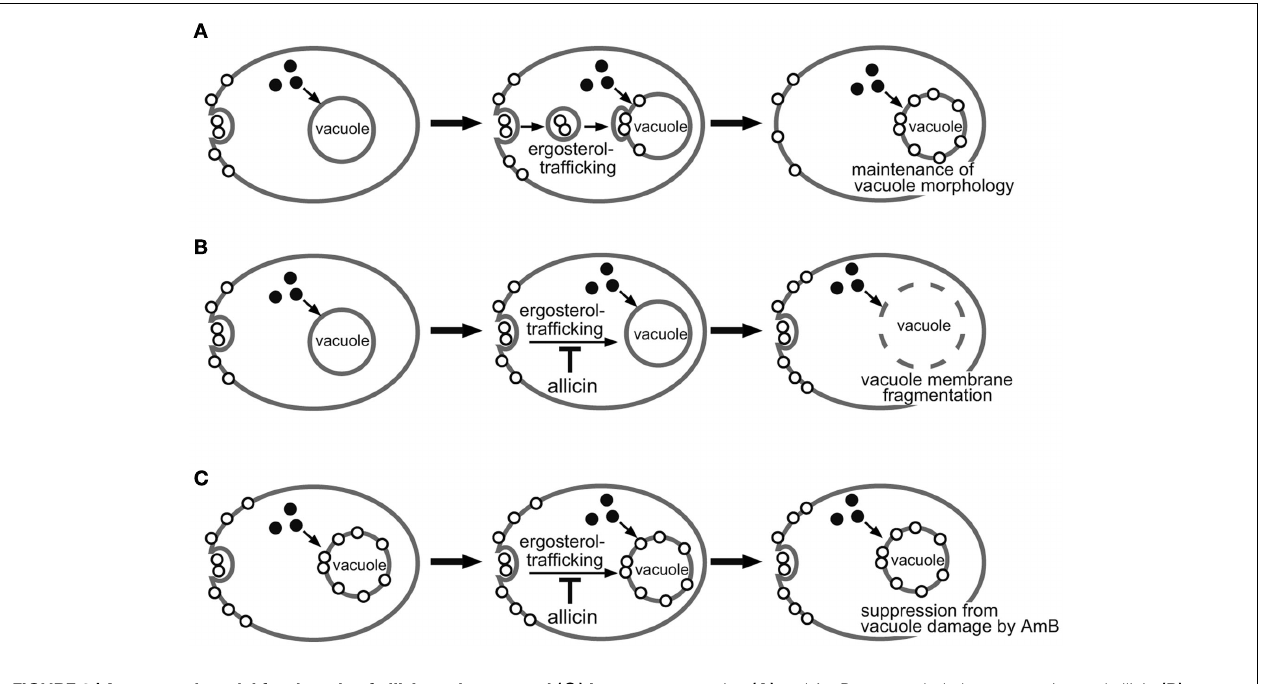
FIGURE 2 |A proposed model for the role of allicin and ergosterol ( the vacuole-targeting fungicidal activity of amphotericin B (AmB) ( Untreated cells were incubated in the presence of AmB alone at a non-lethal